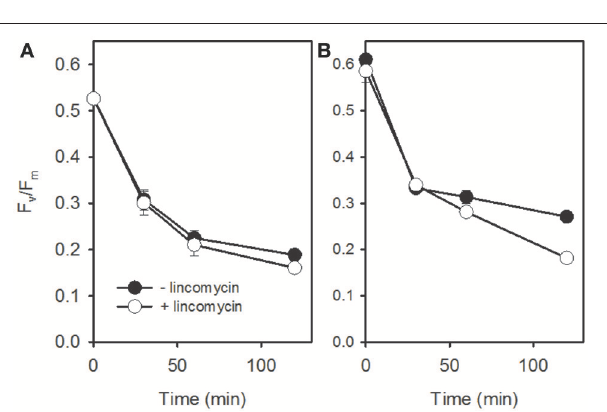
FIGURE 4 | Apparent maximum quantum yield (F v /F m ) in cells of T. gravida acclimated to 0 ◦ C (A) and 5 ◦ C (B) during a 120min shift from 50 µ mol photons m − 2 s − 1 to 400 µ mol photons m − 2 s − 1 in the presence (open circles) and absence (closed circles) of lincomycin. Each data point is the mean of 3 independent cultures, error bars represent standard deviations.